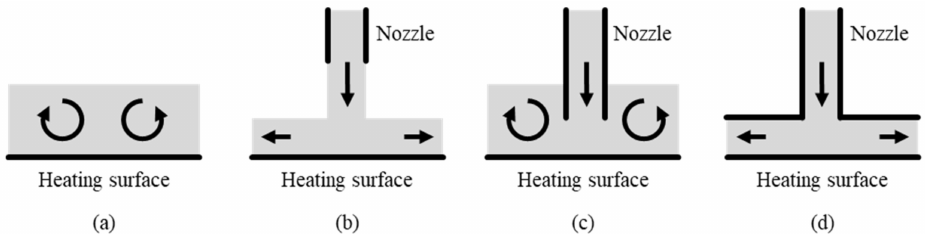
Figure 2. Types of submerged two-phase boiling. ( a ) Pool boiling. ( b ) Jet impingement. ( c ) Submerged jet impingement. ( d ) Confined jet impingement.